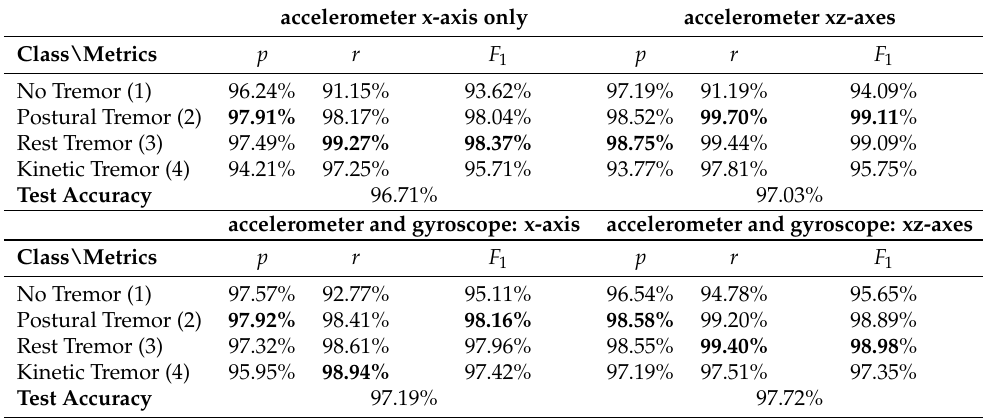
Table 7. Classification performance results in different conditions for accelerometer and